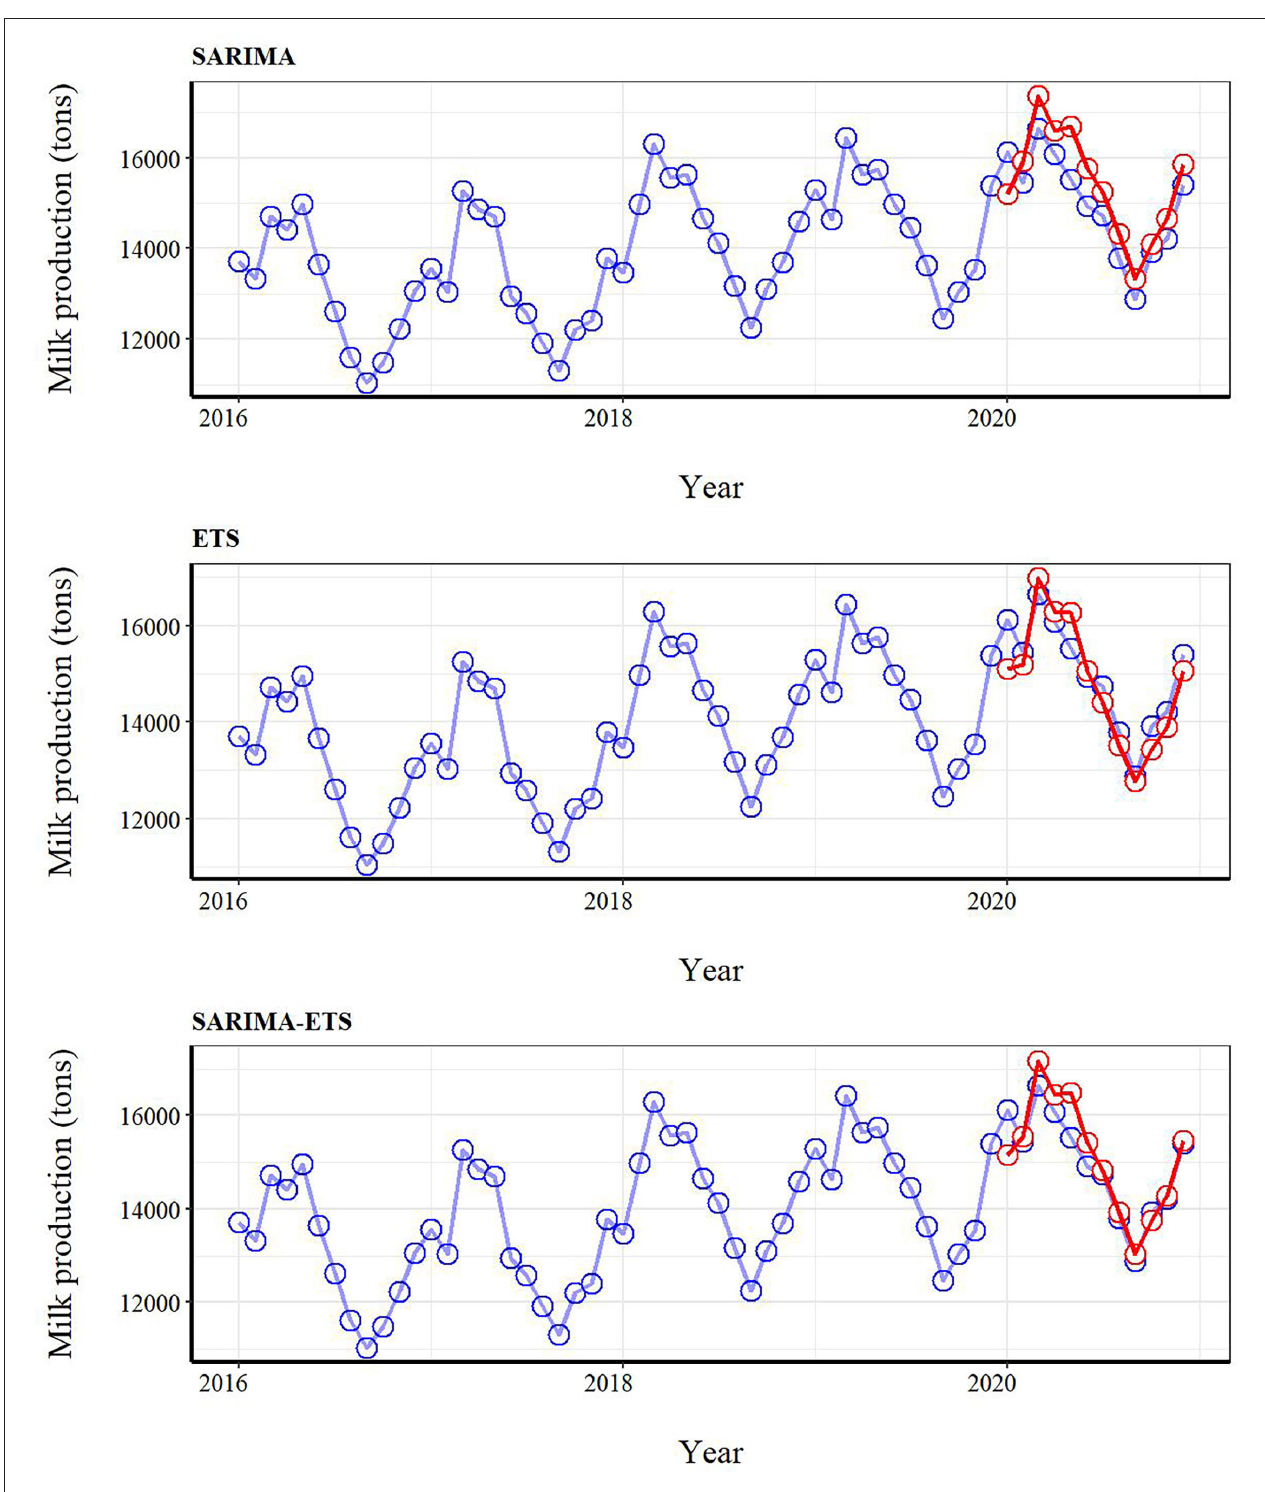
FIGURE 3 | The actual milk production (blue circles) from the full dataset (January 2016–December 2020) and forecast milk production values (red circles) for January-December 2020 derived from seasonal autoregressive integrated moving average (SARIMA), error trend seasonality (ETS), and SARIMA-ETS hybrid models applied to the training dataset. The performance of time series models was measured by comparing forecasted and milk production values from January to December 2020.